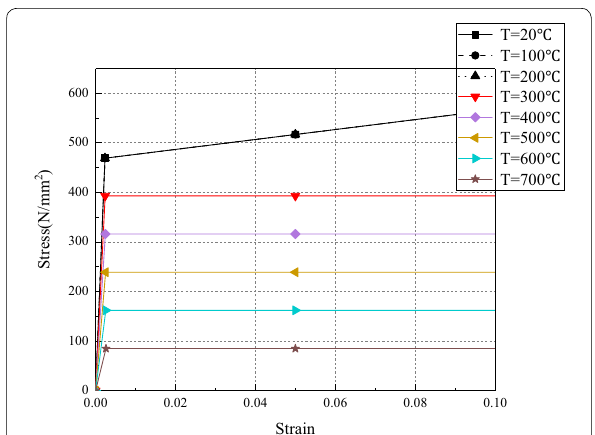
Fig. 15 The stress–strain curves of steel at different temperature